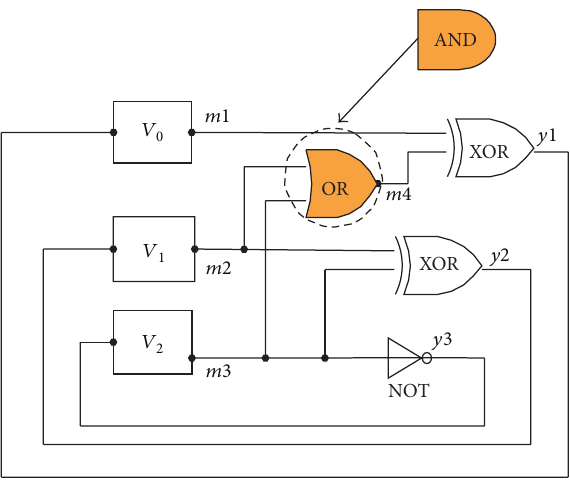
Figure 3: Synchronous